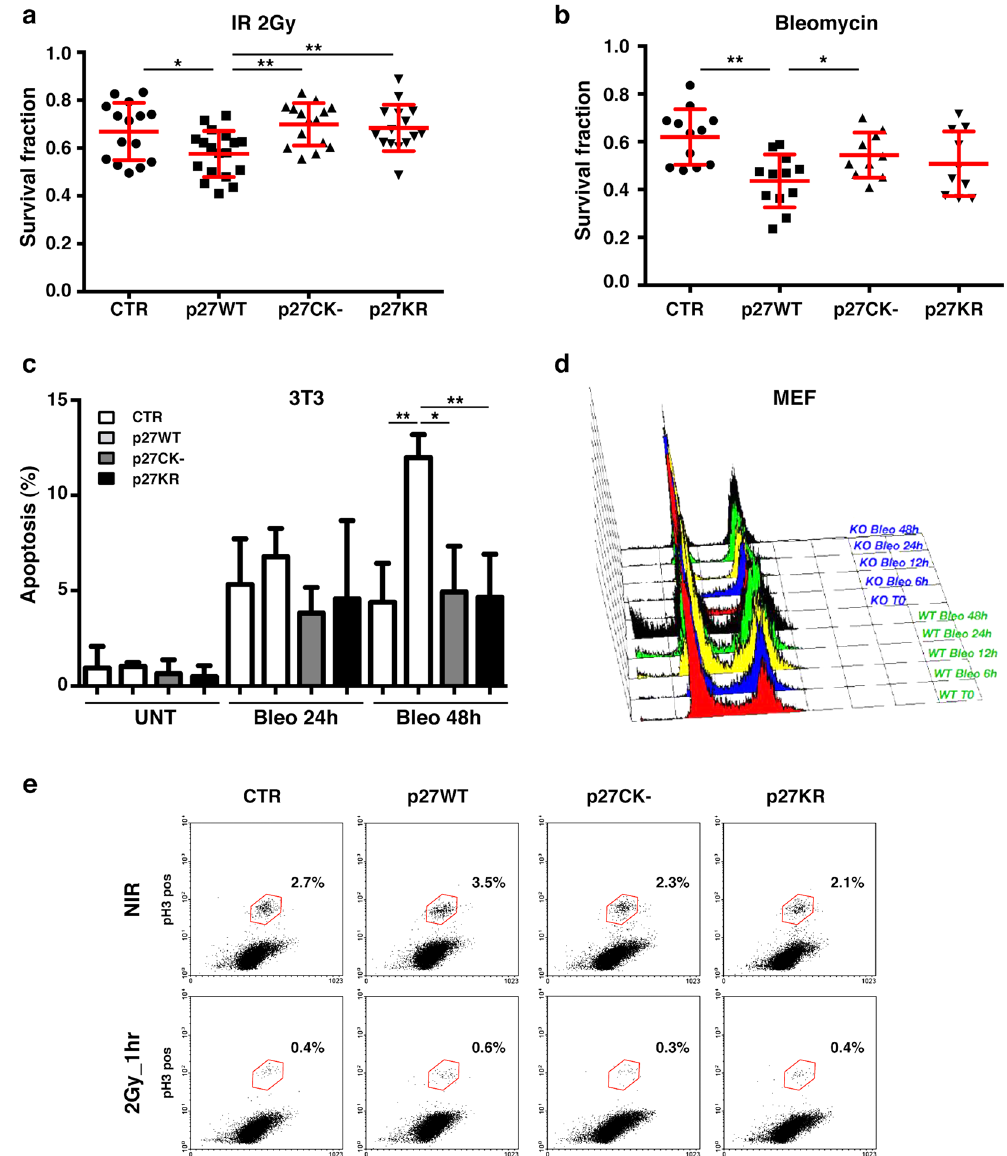
Figure 4. p27KO cells display survival advantage after genotoxic stimuli. ( a ) Graph reports the survival fraction of the different cell clones subjected to 2 Gy IR and then plated in clonogenic assay. Data are expressed as mean of three independent experiments performed at least in triplicates, with SD. ( b ) Graph reports the survival fraction of the different cell clones subjected to the radiomimetic agent Bleomycin (6.25 µ g/ml for 2 hours) and then plated in clonogenic survival assay. Data are expressed as mean of three independent experiments performed at least in triplicates, with SD. ( c ) Graph reports the percent of apoptotic 3T3 p27KO (used as control = CTR) and mutant clones, after treatment with Bleomycin (6.25 µ g/ml for 2 hours) at 24 and 48 hours. Apoptotic cells were assessed by nuclear morphology and membrane integrity after DAPI staining. ( d ) Graph reports the cell cycle distribution, evaluated by FACS analysis, of mouse fibroblasts from WT and p27KO embryos (MEF), treated with Bleomycin (5 µ g/ml for 2 hours) for the indicated time points. ( e ) Plots report the percent of pS10-H3 positive cells 1 hour after 2 Gy IR or NIR, evaluated by FACS, in 3T3 p27KO (CTR) and mutant clones, as indicated. * Indicates a p ≤ 0.05; ** p ≤